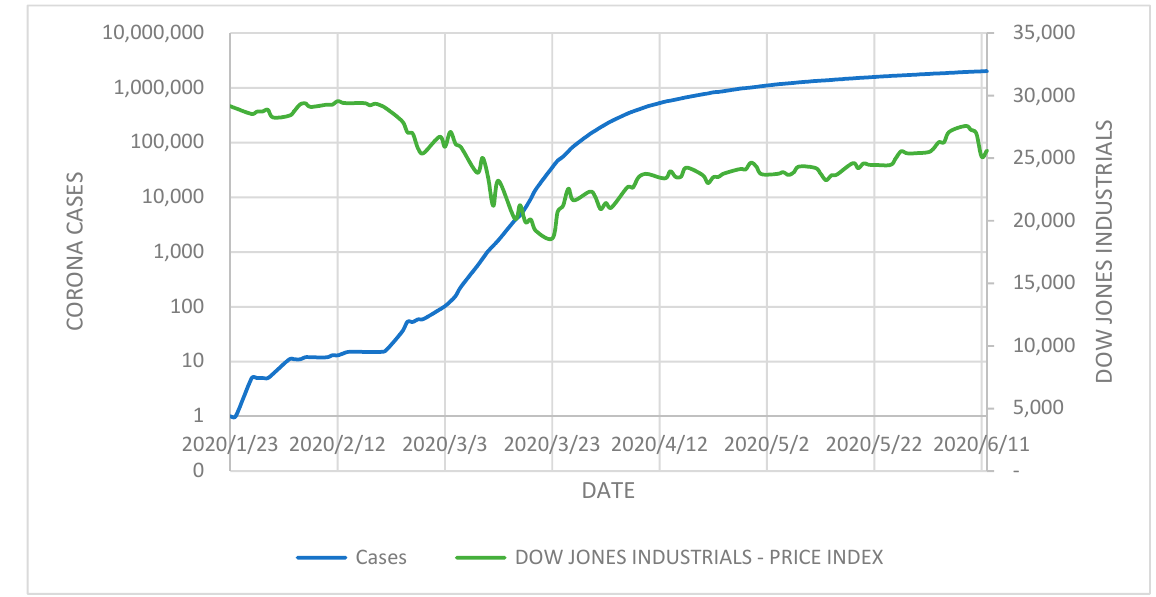
Figure 1. Movements of coronavirus cases and the Dow Jones Industrial Index during the COVID-19 period. Sources: https://www.investing.com; https://ourworldindata.org/coronavirus-data.